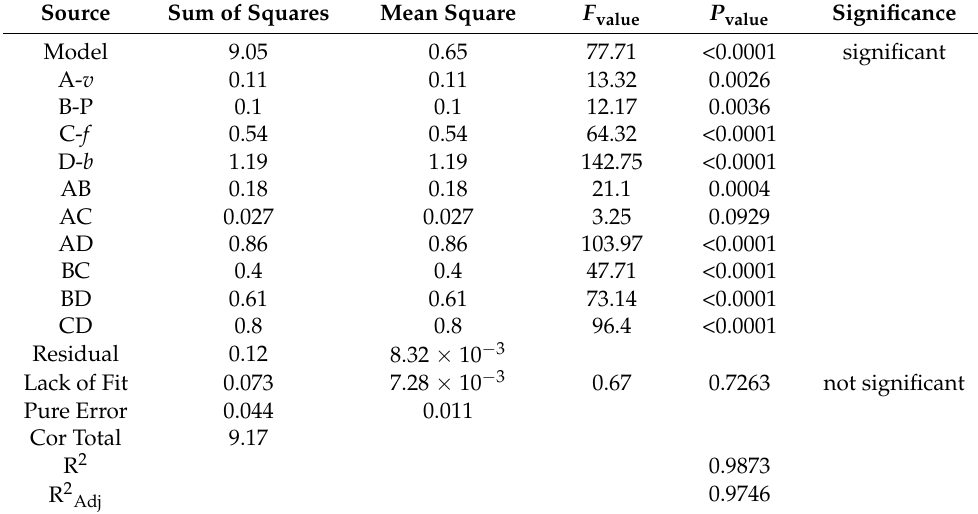
Table 4. Response surface ANOVA